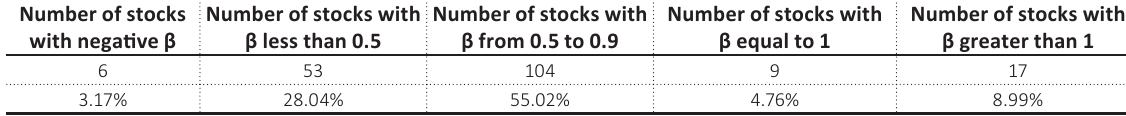
Table 2. Beta ( β ) value of stocks listed in Tadawul as of 2019 Number of stocks Number of stocks with with negative β β less than 0.5